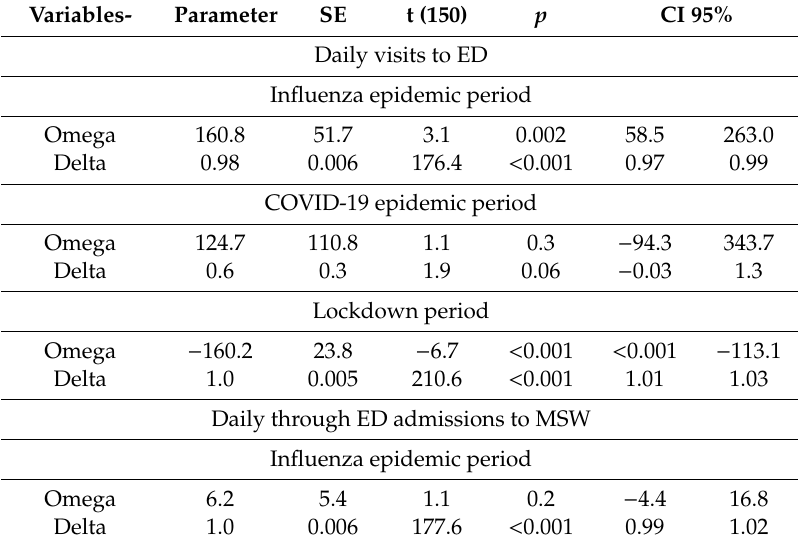
Table 1. Time series analysis Interrupted autoregressive integrated moving average (ARIMA) models for influenza epidemic, COVID-19 epidemic, and lockdown and containment periods.